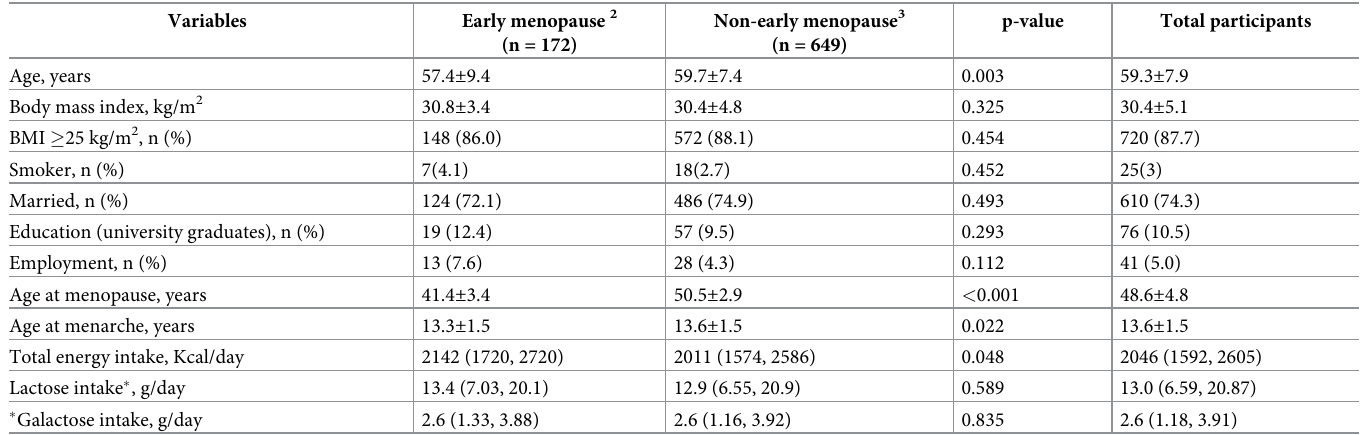
Table 1. Characteristics of participants based on age of menopause 1